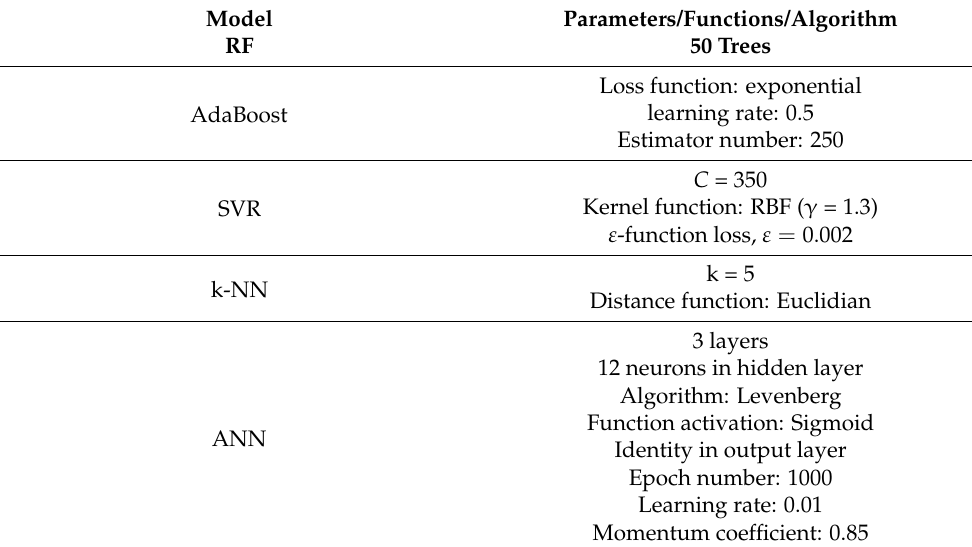
Table 4. Adopted hyper-parameter and functions of the trained models. Model